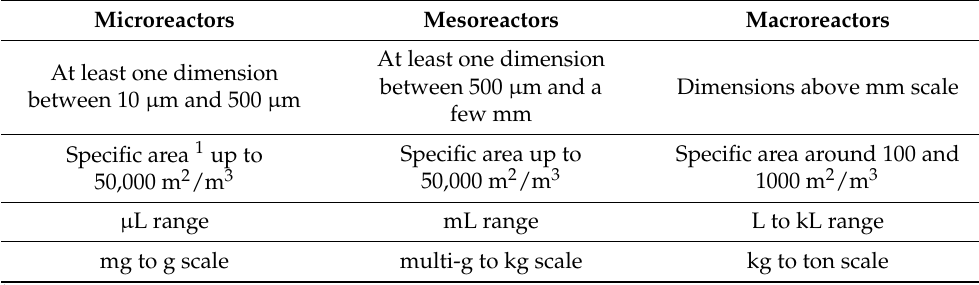
Table 1. Typical metrics of micro-, meso- and macroreactors.